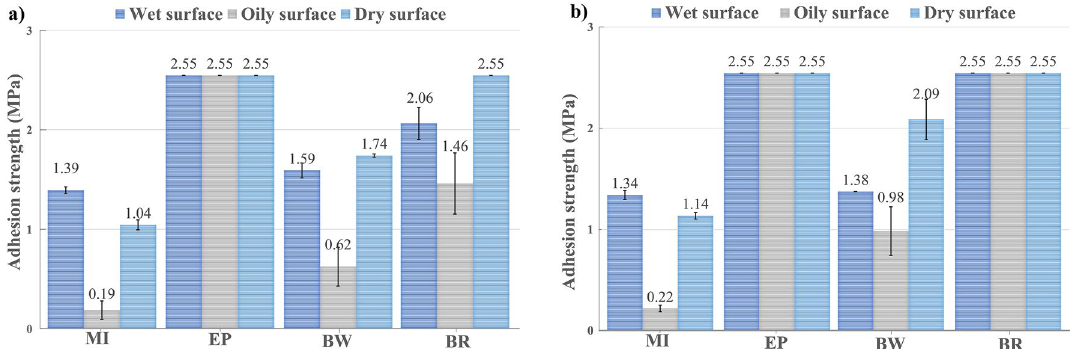
Figure 7. Average adhesion test in concrete slabs ( a ) Samples air-dried for 28 days ( b ) Samples air-dried for 14 days + oven-dried for 14 days.